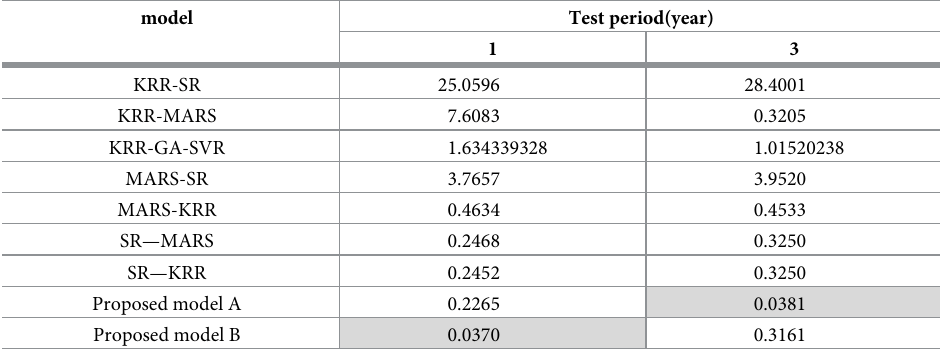
Table 9. Performance comparisons for China Steel.